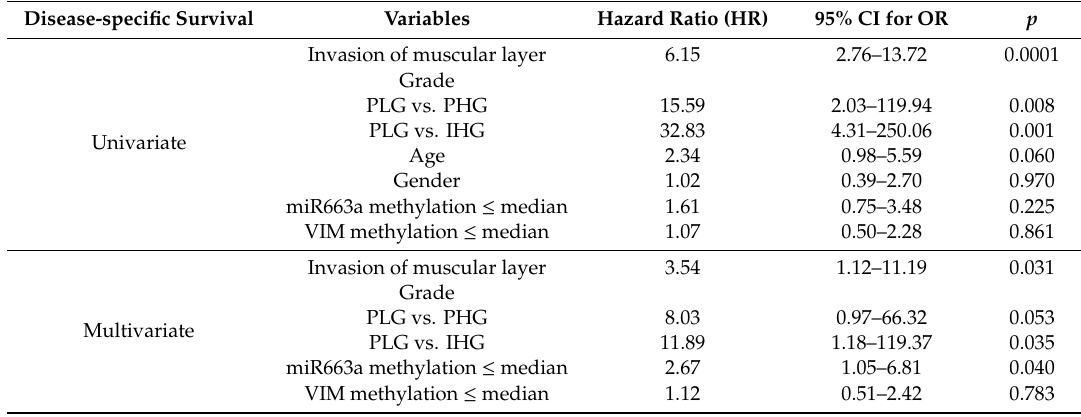
Table 3. Cox regression models assessing the potential of clinical and VIMme and miR663ame levels in the prediction of disease-specific survival for bladder carcinoma (BlCa)